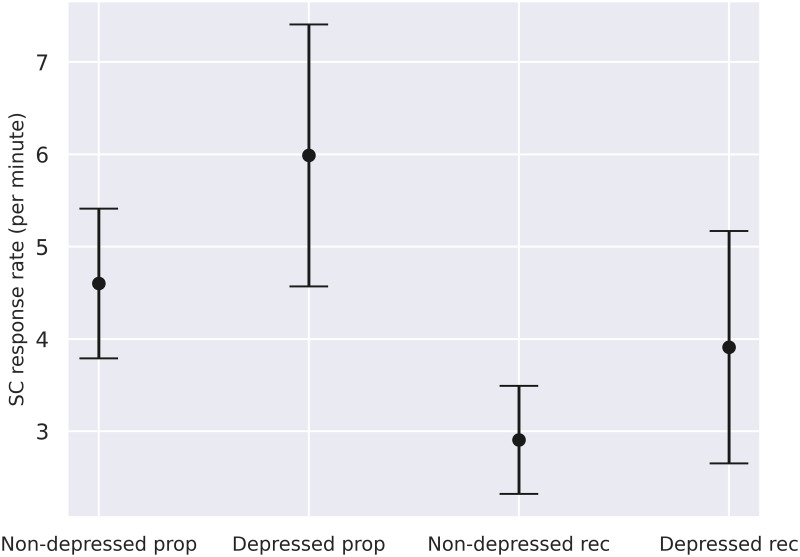
SC response rates in non-depressed and depressed proposers (prop) and recipients (rec).The black dots indicate means while the black bars represent 95% confidence intervals.